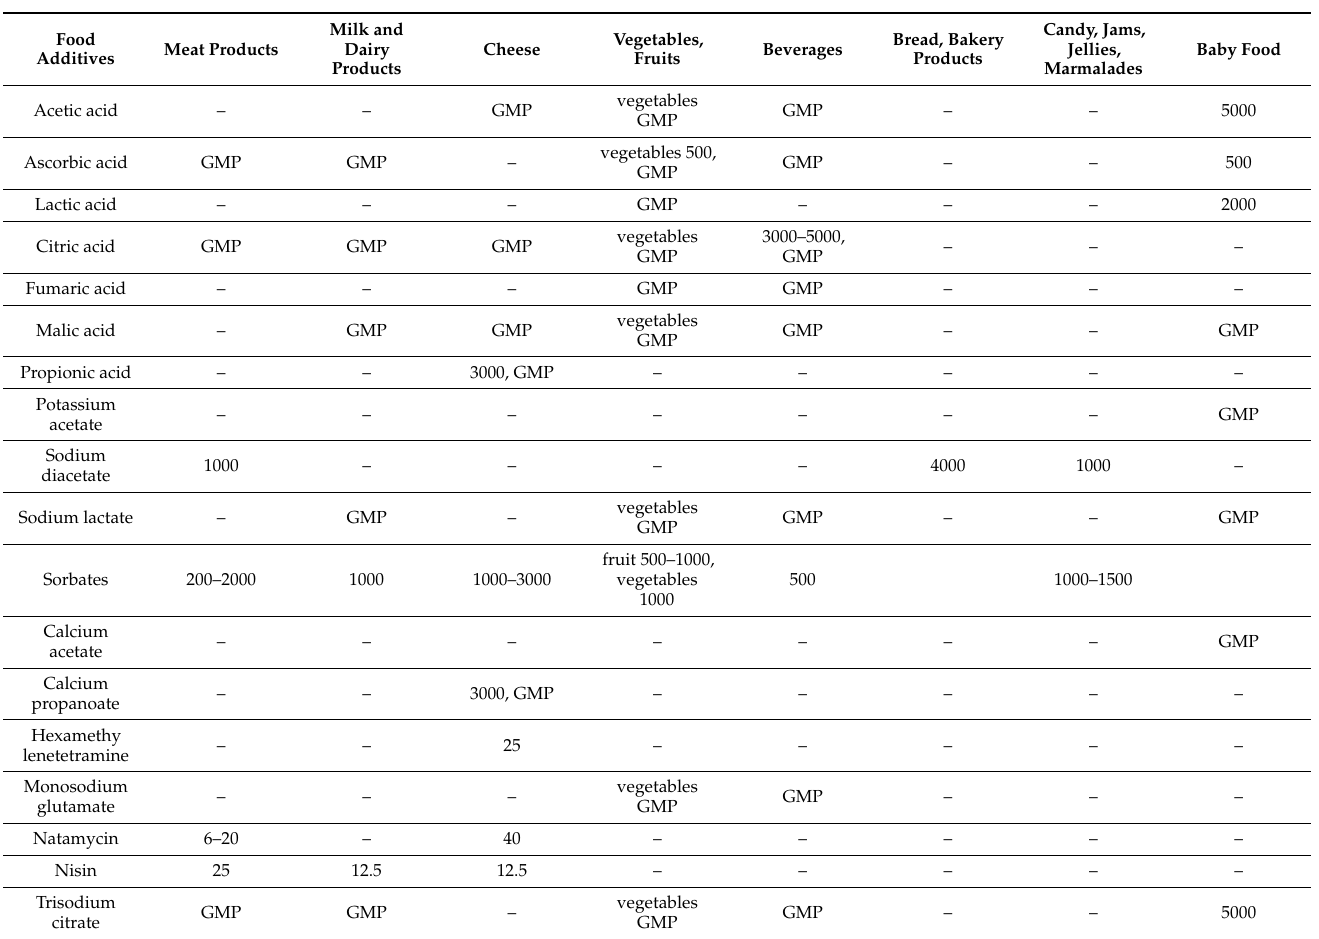
Table 2. Maximum level (mg/kg) of food additives permitted for use by the Codex Alimentarius in basic human